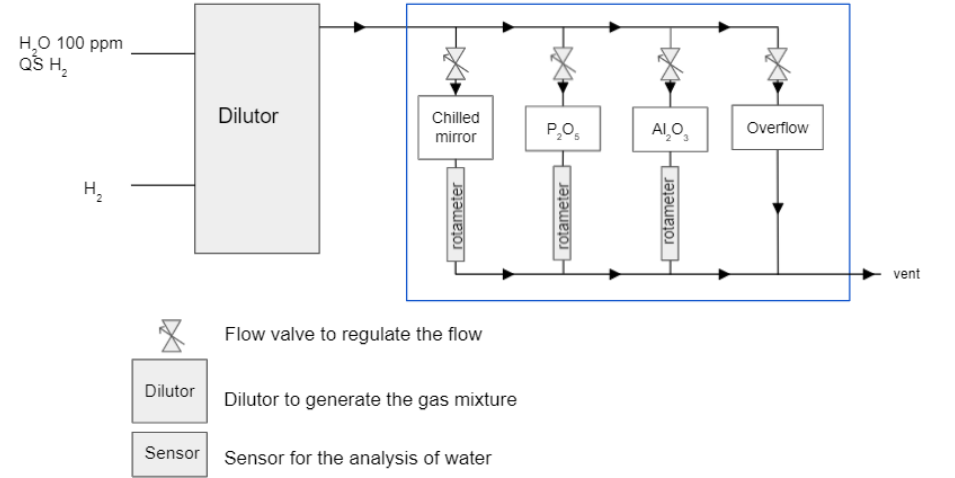
Figure 4. Testing rig developed by Air Liquide facility for simultaneous testing of several sensors.